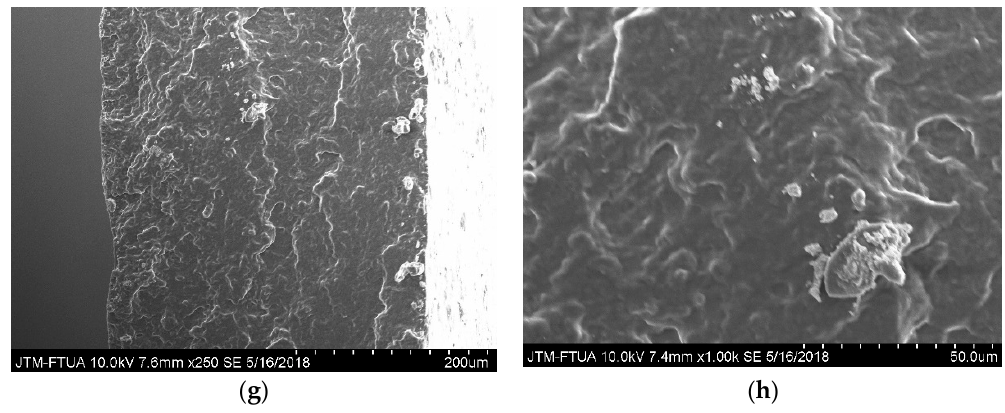
Figure 6. SEM micrograph of fractured cross section of the ( a ) Control; ( b ) BC-2; ( c ) BC-6; ( d ) BC-10 in X250; ( e ) Control; ( f ) BC-2; ( g ) BC-6; ( h ) BC-10 in X1000.